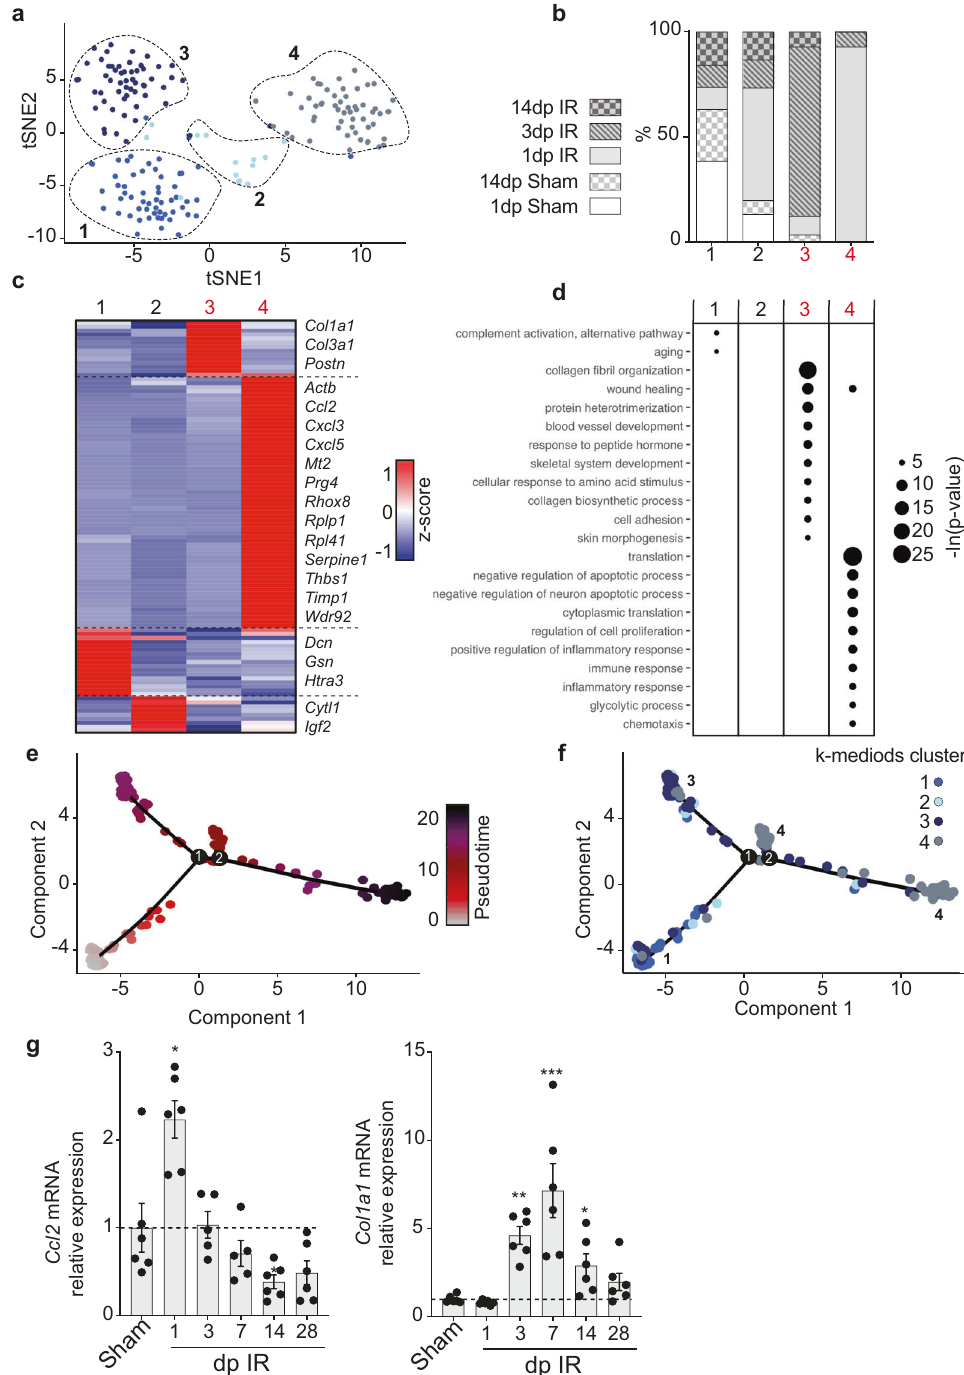
Fig. 4 Transcriptome-wide changes in fi broblasts at different stages after ischemic injury suggest dynamic fi broblasts function during wound healing. a tSNE plot indicating transcriptomic similarities across fi broblasts obtained from all conditions. Different colors and numbers highlight the clusters as determined by k-medoids clustering of 1 − Pearson ’ s correlation coef fi cient. b Bar graph showing the proportion of fi broblasts originating from the different conditions per cluster. c Heatmap showing expression of all genes signi fi cantly enriched in at least one cluster. Examples of genes enriched per cluster are depicted on the right side of the heatmap. d Bubble plot of gene ontology analysis on genes signi fi cantly enriched within a cluster. b – d Numbers highlighted in red depict clusters that mainly contain 1 dp IR (cluster 4) or 3 dp IR (cluster 3) fi broblasts. e , f , Cell trajectory analysis of fi broblasts, showing pseudotime on a color-coded scale ( e ) or highlighting the k-medoids cluster of each fi broblast in the trajectory plot ( f ). The branches in the trajectory plot that contain mostly cells from k-medoids cluster 1, 3 or 4 are highlighted by number. g RT-qPCR analysis on the infarcted cardiac tissue at different time points post IR for Ccl2 and Col1a1 . Per time point post IR, expression levels are relative to the corresponding time point post sham surgery ( n = 6 animals). Data are presented as mean ± SEM. * P < 0.05, ** P < 0.01, *** P < 0.001, Two-sample t -test vs the corresponding time point post sham, with Holm – Sidak adjustment for multiple